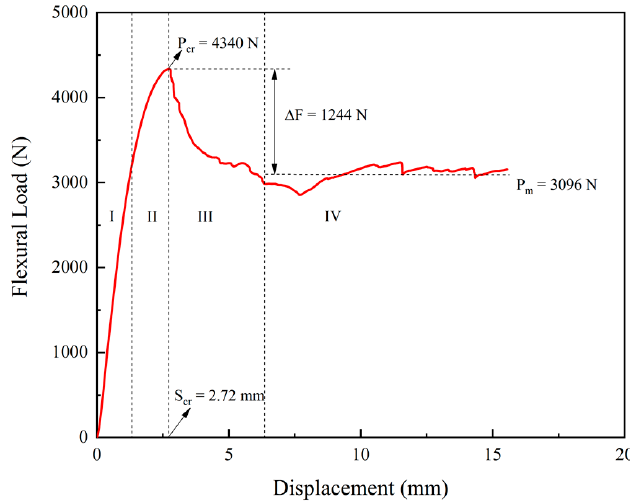
Figure 4. Analysis of flexural load–displacement curve of #20-0.37.